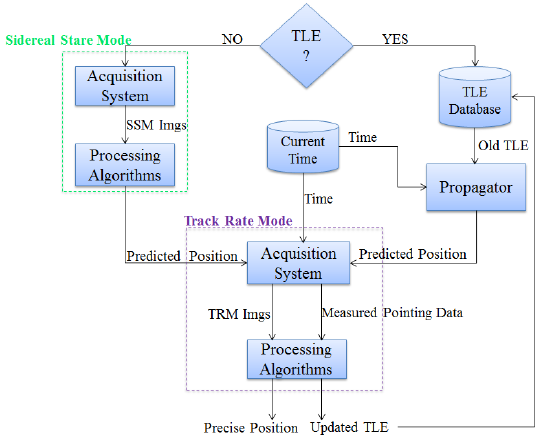
Figure 1. General framework of detection and tracking the satellite